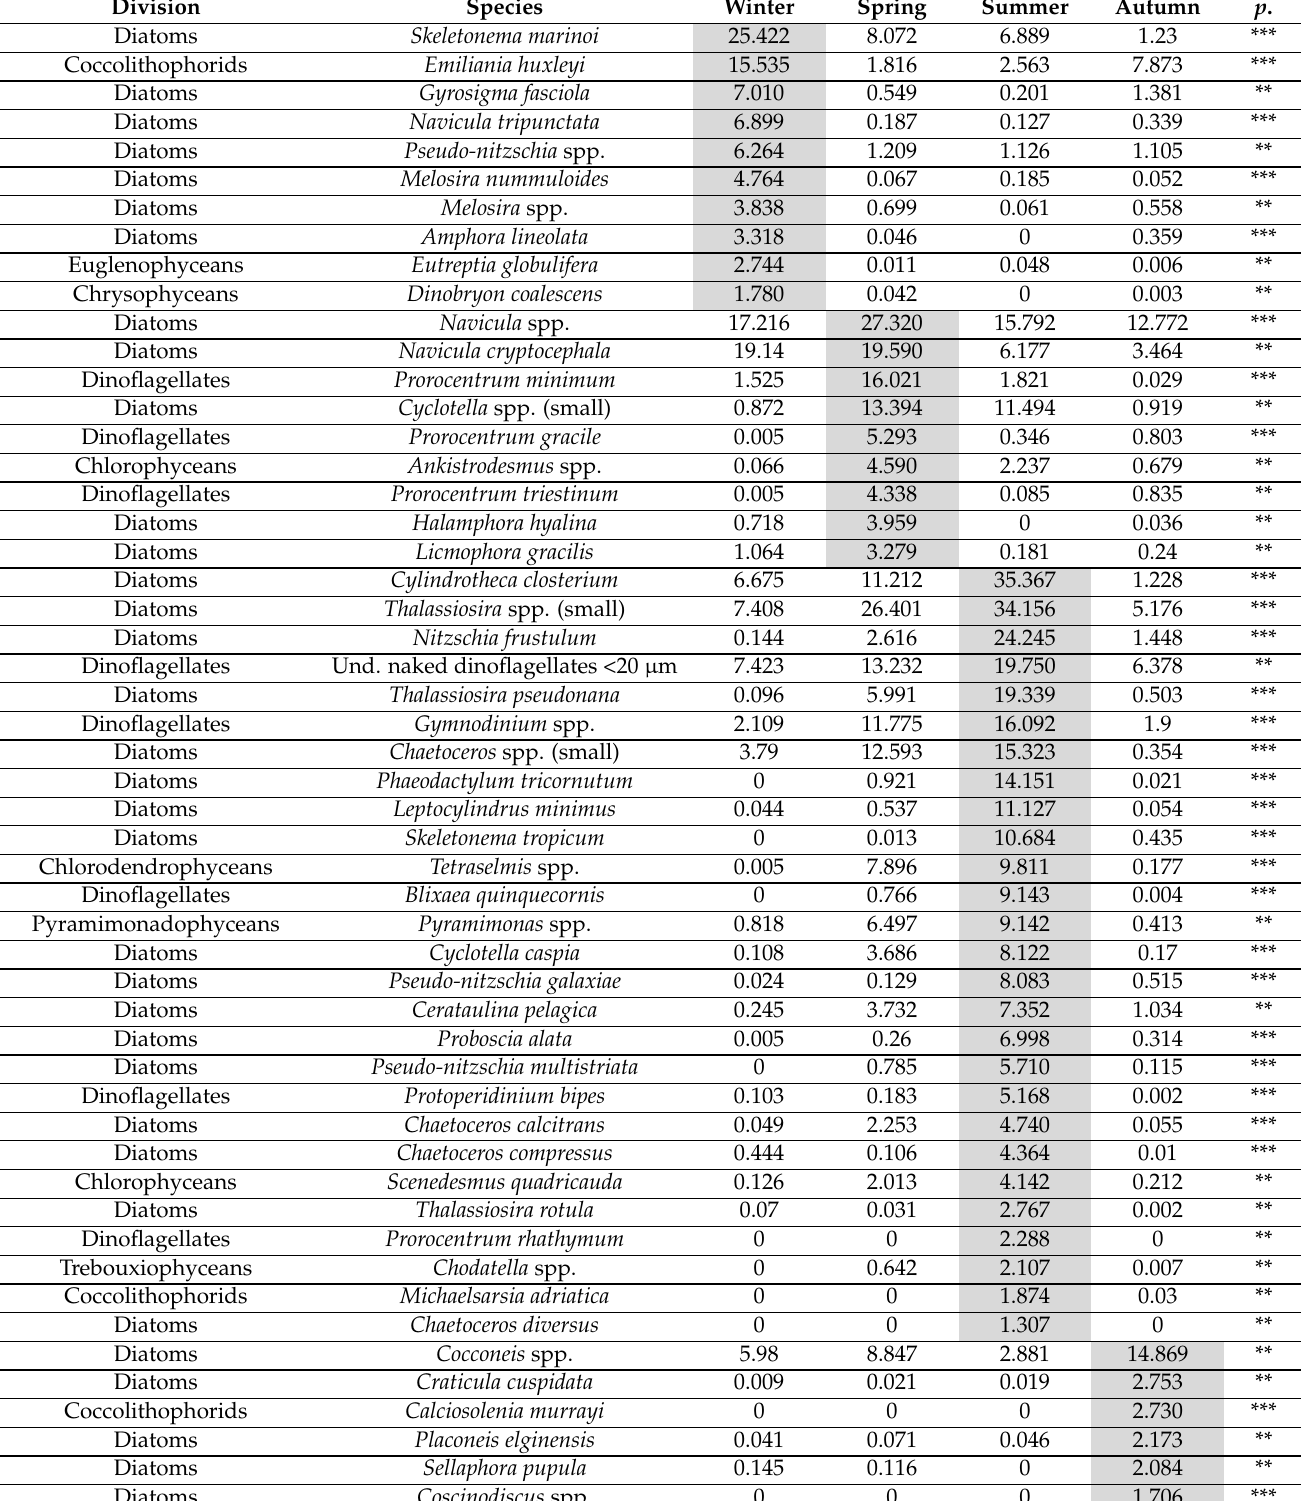
Table 3. List of main phytoplankton taxa characterized by the highest and significant IndVal for each season in the period 1998–2017. For each taxa, we also indicate the divisions to which they belong. IndVal values indicated with ** are significant at p < 0.01, and those with *** are significant at p < 0.001. Taxa are listed in order of decreasing importance in each